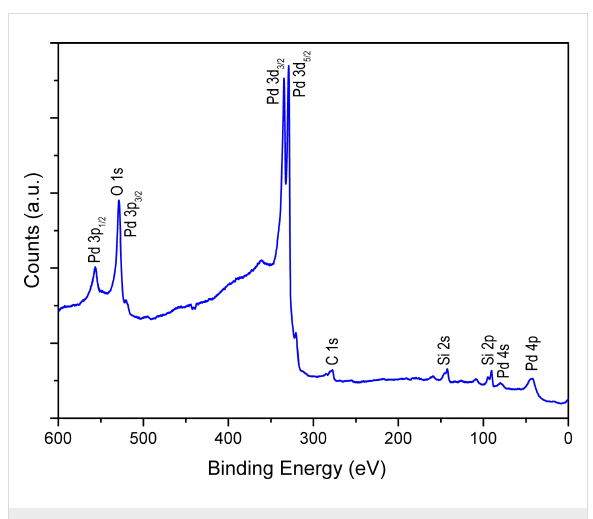
Figure 11: XPS survey spectrum of metallic